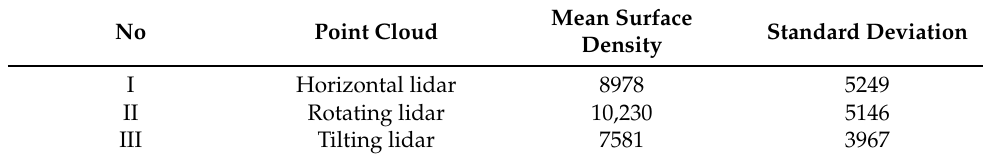
Table 1. Density statistics in points per m 2